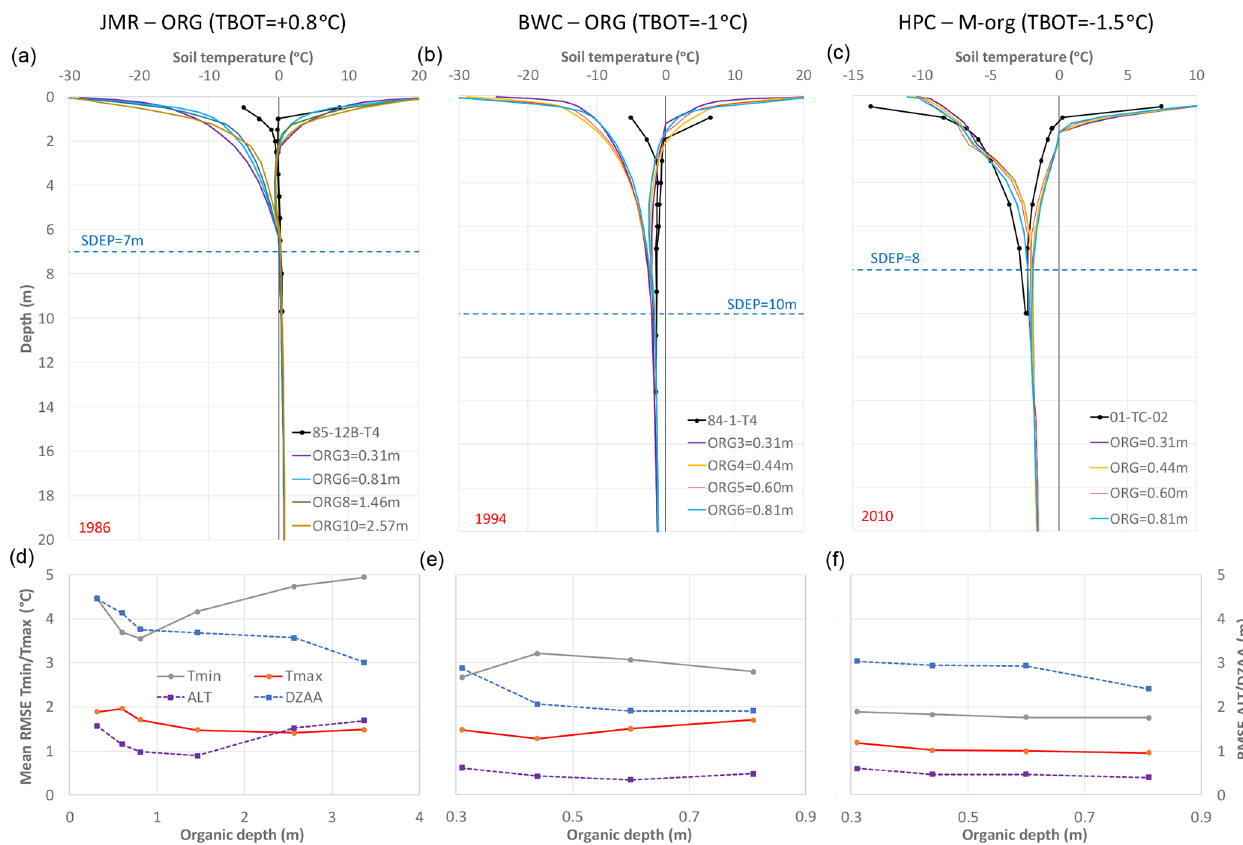
Figure 17. Impact of organic depth on simulated temperature envelopes for a selected year at each study site (a–c) . RMSE for temperature envelopes (Tmax and Tmin), ALT and DZAA (d–f) over the simulation period for the needleleaf forest GRU at each study